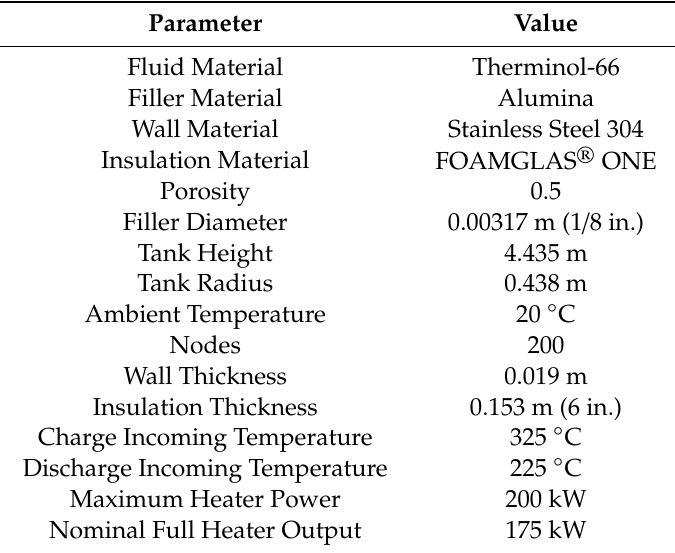
Table 5. TEDS operational